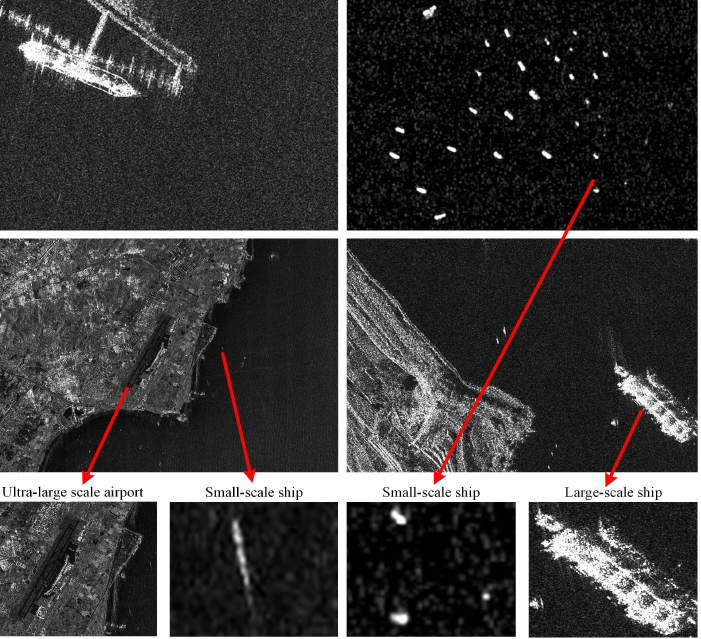
Figure 1. Examples of multiscale targets in SAR images, including small-scale ships, large-scale ships, and ultra-large-scale airports. There are huge differences in the scale between different